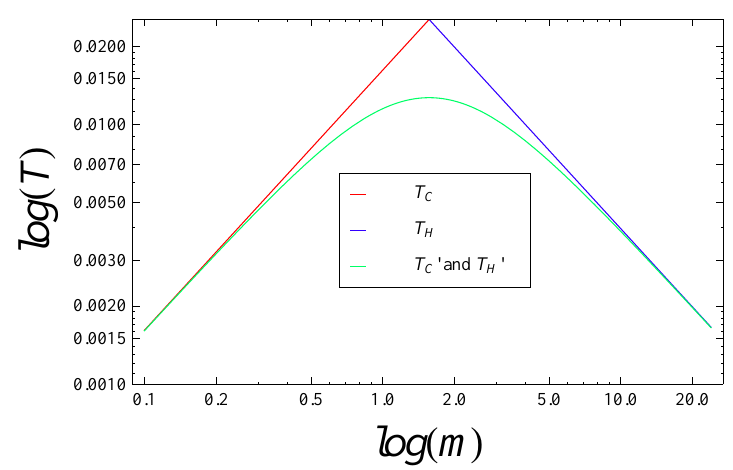
Figure 5. The Compton temperature T C , as defined in the semi-Newtonian approximation of canonical QM (red line), and Hawking temperature T H , derived in semi-classical gravity (blue line). T (cid:48) represents a unified temperature curve, suggested by the theory of extended de Broglie relations C / H (green curve)